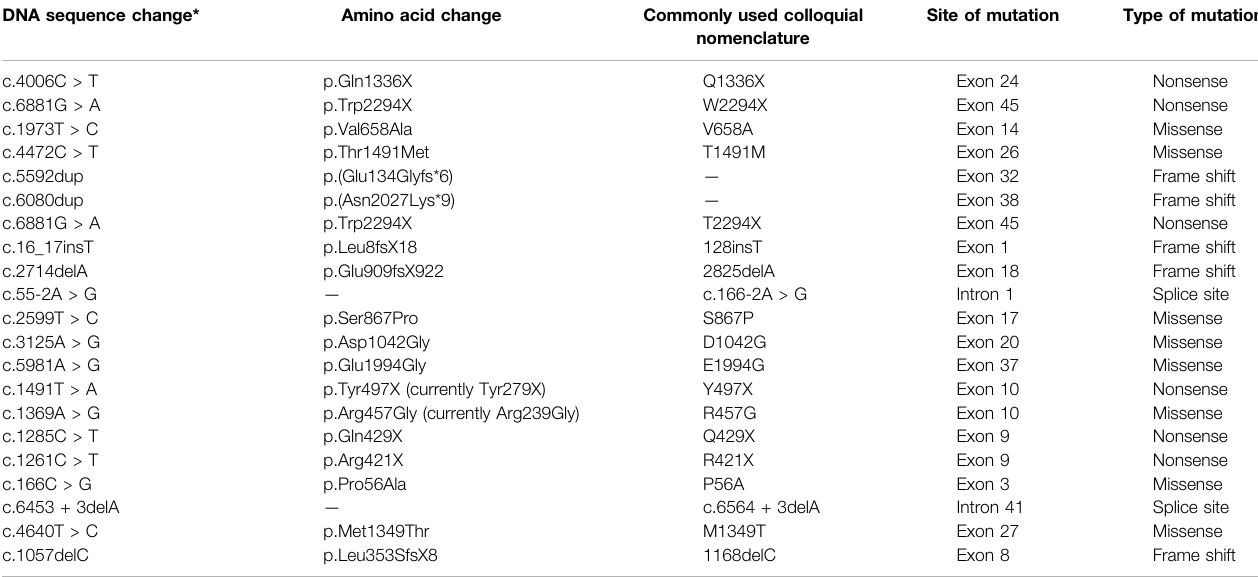
TABLE 1 | Standard and Colloquial nomenclature for PTPRQ mutations and variants. DNA sequence